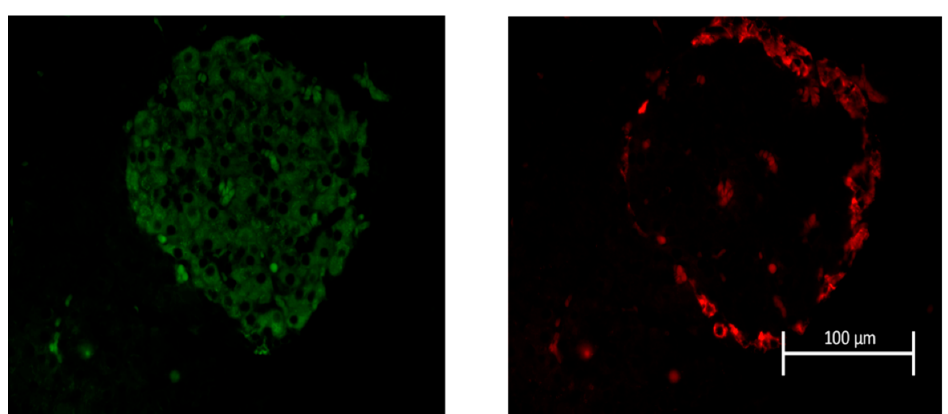
Figure 7. Representative image of insulin and glucagon labelled islet of Langerhans. Pancreatic tissue was collected from 6, 9 and 12 week control ‐ and Cd ‐ treated rats (0.6 mg/kg/day, five days per week, for Cd and equal volumes of saline for control s.c.). Tissue was then immuno ‐ labelled for the presence of β‐ cells with insulin (green) left panel and for α‐ cells with glucagon (red) right panel.